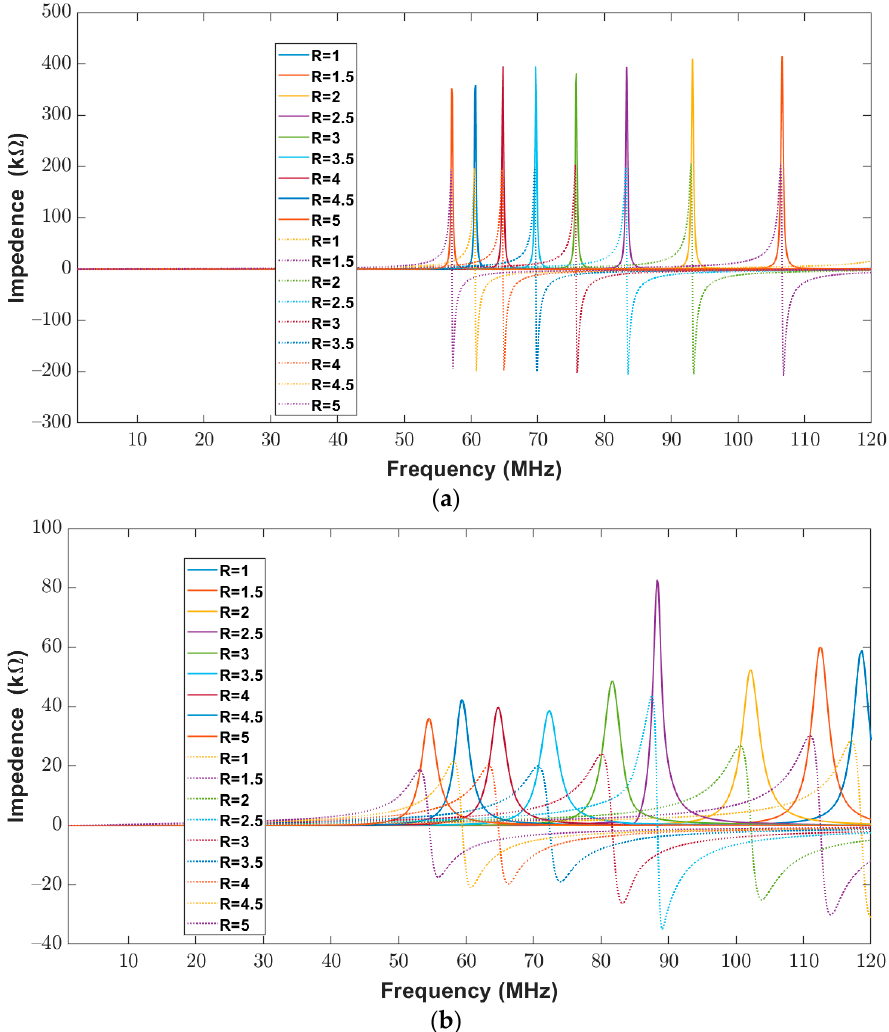
Figure 15. Impedance (Real (solid lines) and Imaginary (dotted lines) components) of elliptical planar inductors for the full range of frequencies from 20 Hz to 120 MHz with varying major-to-minor ratios while trace separation ( S ) and trace width ( W ) were kept constant at 300 μ m ( a ) Computed response using proposed model ( b ) Measured response from the impedance analyzer.